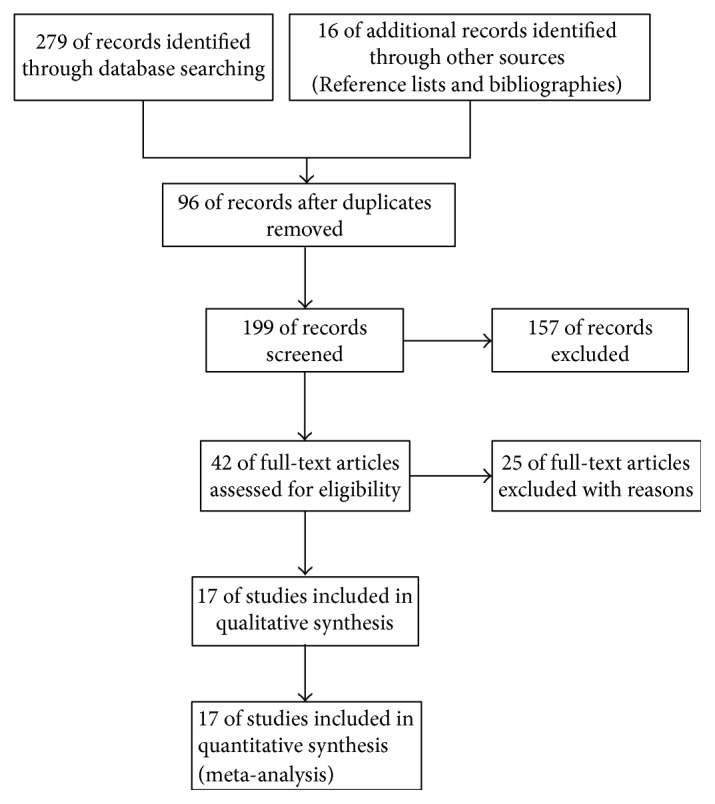
Study flow diagram.